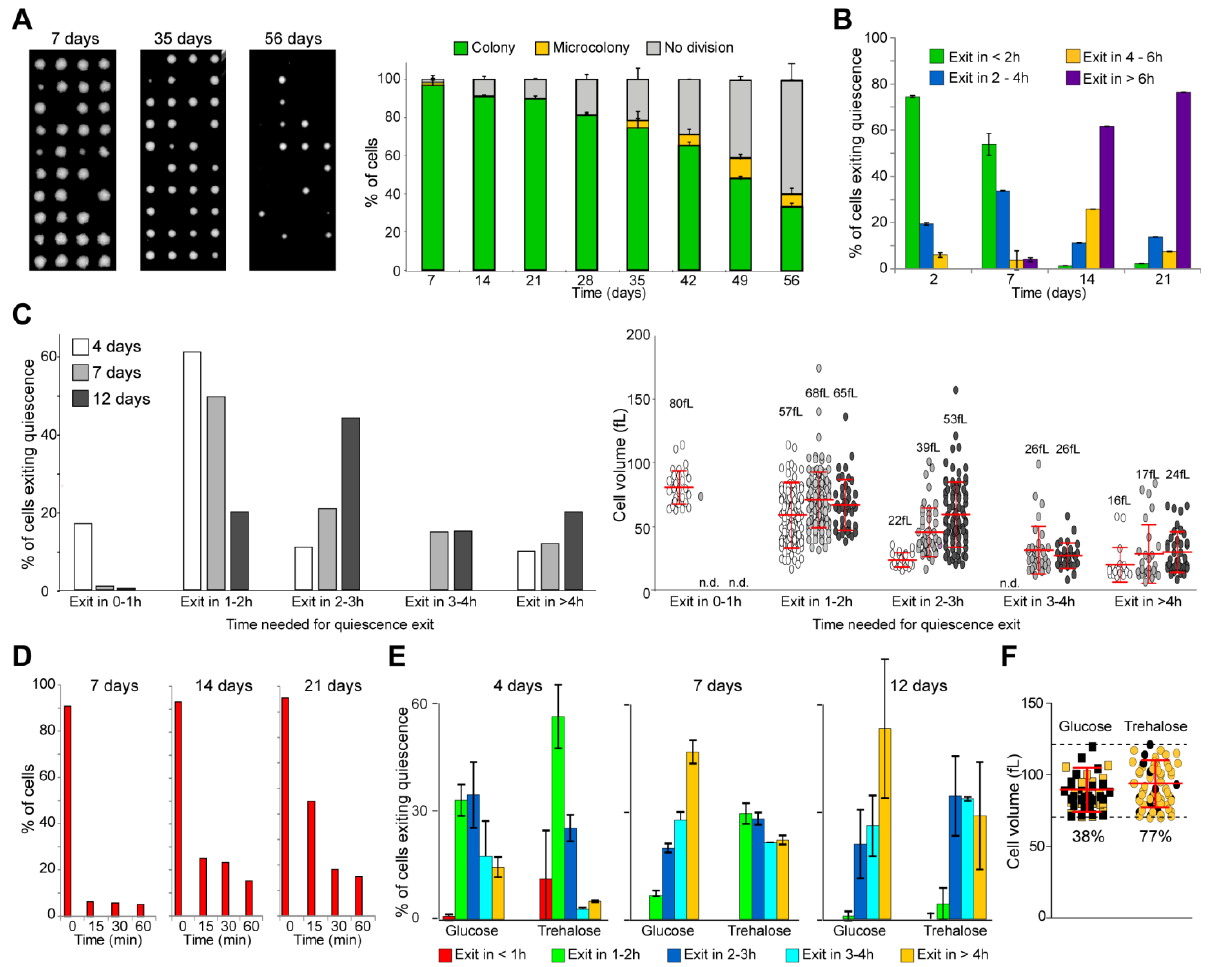
FIGURE 2: Quiescence exit swiftness decreases with chronological age. (A) Cell ability to form a colony decreases with chronological age. Percentage of wild type prototroph FY4 cells able to form a colony in function of the time spend in YPDA at 30°C. Individual cells were iso- lated by micro-manipulation and allowed to grow 3 days at 30°C on YPDA plates (examples are shown). The percentage of cells able to give rise to a colony or a micro-colony (less than 10 divisions) was scored (n=240, N=3). (B) Quiescence exit efficiency in function of chronological age. Wild type cells were grown in YPDA at 30°C for the indicated time and re-fed on a YPD-containing microscope agarose pad. Quiescence exit efficiency was scored for each time point (n>300, N=2). (C) Quiescence exit efficiency in function of chronological age. Wild type cells were grown in YPDA at 30°C for the indicated time, then re-fed on a YPD-containing microscope agarose pad. Left panel: percentage of cells able to exit quiescence within the indicated time frame. Right panel: cell initial volume in quiescence; median volume and SD are indicated. (D) Actin body mobilization upon quiescence exit. Wild type cells expressing the actin binding protein Abp1-3xGFP were grown in YPDA at 30°C. Glucose (4% final) was added to the medium and the actin cytoskeleton organization was analyzed (n>200, N=2). (E) Trehalose influ- ences quiescence exit efficiency. Wild type prototroph CEN-PK cells were grown 24 h in YP pH 5 containing 4% glucose or 2% glucose + 2% trehalose, then washed and inoculated in YP without sugar for the indicated time. Quiescence exit was triggered on a YPD-containing micro- scope agarose pad, for each time point n>100 N=2. (F) Cell’s ability to exit quiescence after 12 days of culture in the presence of 4% glucose or 2% glucose + 2% trehalose, within the initial volume range of 70 to 120 fL (n>45). Number are the percentage of cells exiting quiescence in less than 2 h (in yellow) within all the cells capable of exiting quiescence (quiescence exit in > 2 h in black). Histograms represent means and bars are